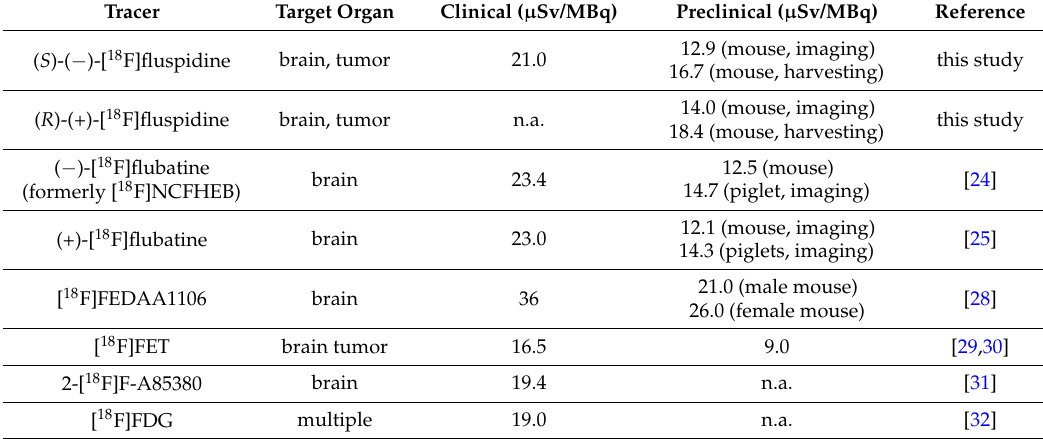
Table 4. Comparison of dosimetry results (ED) for different PET tracers including the current study with [ 18